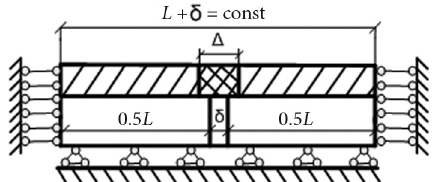
Fig. 13. Design model for the calculation of stresses in asphalt concrete pavement after the repair and re-crack formation after crack formation in a sealant